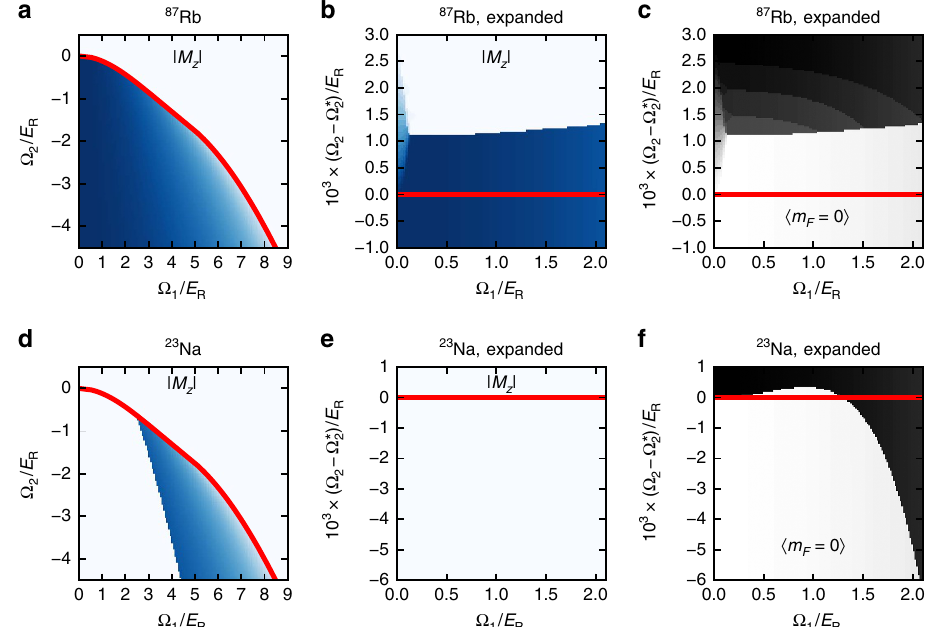
Figure 5 | Mean field phase diagram. ( a – c ) Rubidium. ( d – f ) Sodium. In each panel, the red curve marks the location of the phase transition as computed excluding interactions. ( b , c , e , f ) Expanded views of the region around the critical curve. a , b , d and e plot the | M z | order parameter: the plot is dark blue